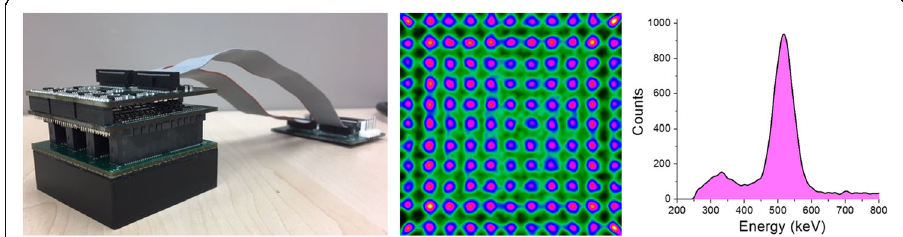
Fig. 3 Left, photograph of the detector block, photosensor, and frontend electronics. Center, calibrated flood map of the 11 × 11 sources array used of position calibration. Right, calibrated energy profile